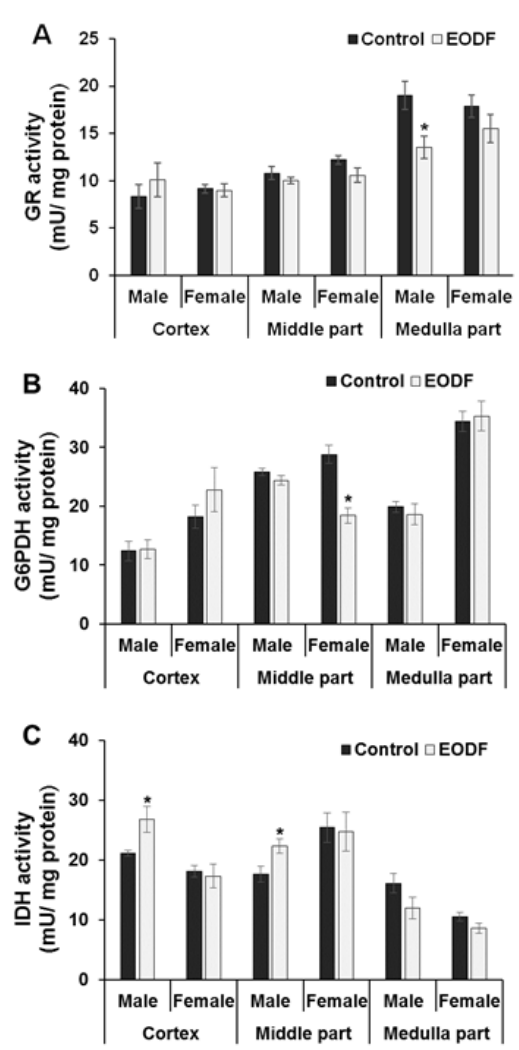
Figure 4: The effect of EODF on the activities of the enzymes responsible for maintaining glutathi- one redox status: ( A ) glutathione reductase ( n = 5-6), ( B ) glucose-6-phosphate dehydrogenase ( n = 4-6), and ( C ) NADP-dependent isocitrate dehy- drogenase ( n = 4-6) in different parts of the brain of young mice. Data are mean ± SEM. *Signifi- cantly different from the corresponding values for ad libitum fed (control) group, P <